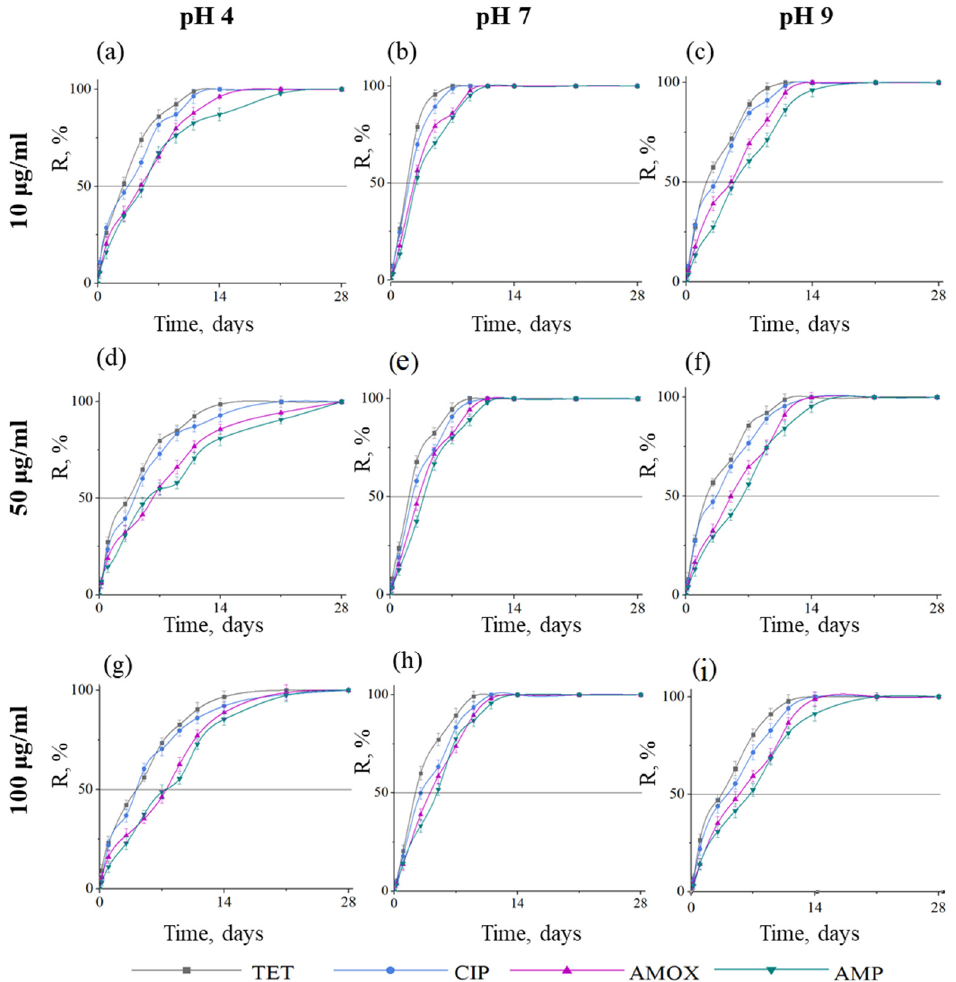
Figure 2. Kinetic curves showing the removal efficiency of four types of antibiotics with BN coated samples at pH 4 ( a , d , g ), pH 7 ( b , e , h ), and pH 9 ( c , f , i ) and initial antibiotic concentrations of 10 ( a – c ), 50 ( d – f ) and 100 µg/mL ( g – l ). T = 25 °C.